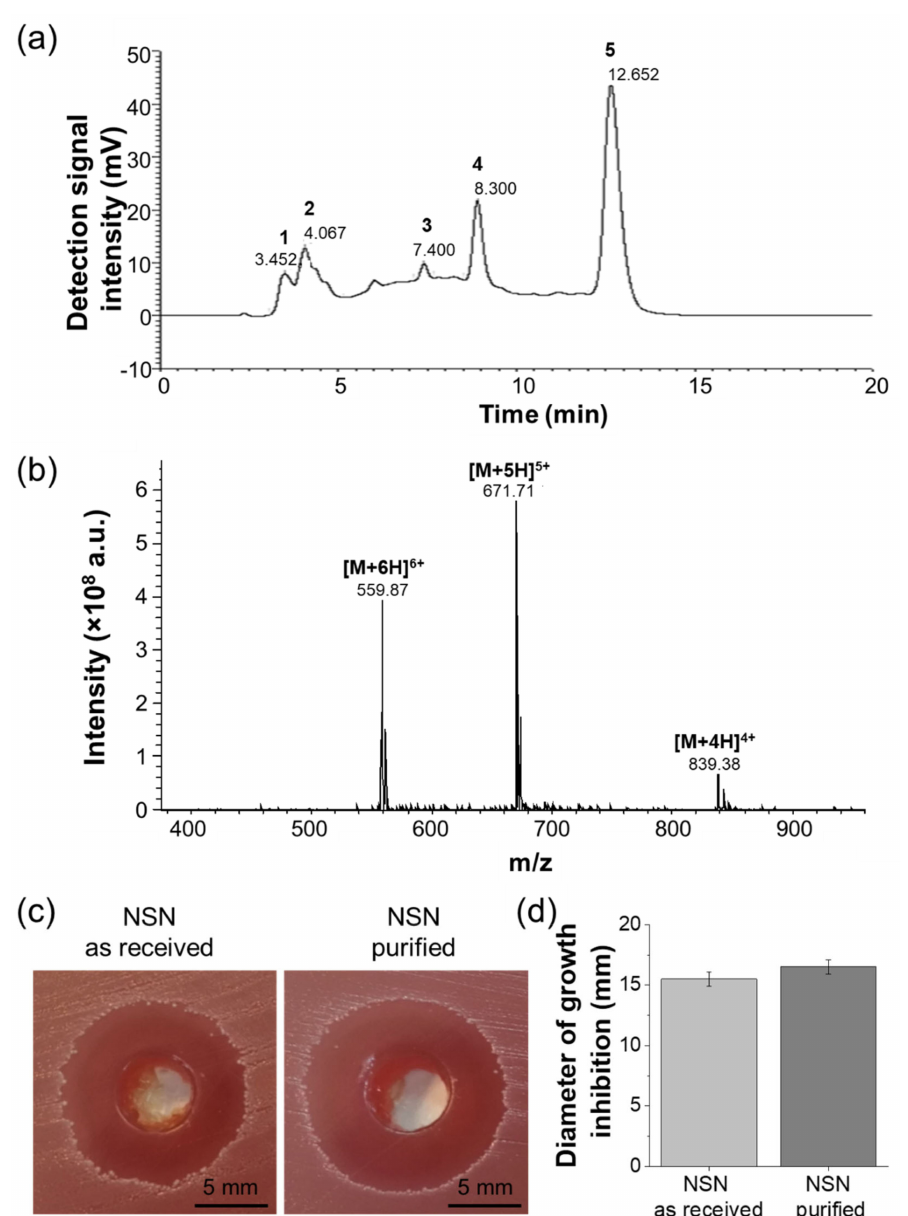
Figure 1. Nisin purification: HPLC chromatogram of NSN after reverse-phase purification ( a ), the mass spectrum of NSN ( b ), pictures of S. pyogenes growth inhibition zones ( c ) and diameters of S. pyogenes growth inhibition zones ( d